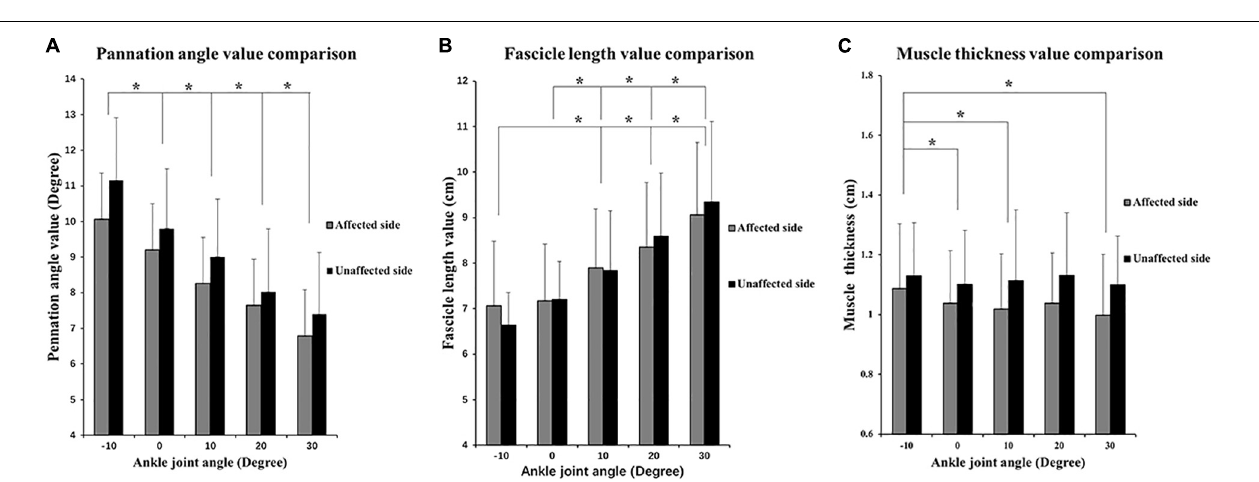
FIGURE 4 | Two-way repeated ANOVA with post hoc analysis results of ultrasonography parameters. (A) PA values comparisons among five ankle joint angles. (B) Fascicle length (FL) values comparison among five ankle joint angles, and significant difference was revealed between random two groups of ankle joint angles. (C) MT value comparison among five ankle joint angles. Y axis of A , B , and C did not start from 0 to demonstrate the variation trend of parameters versus joint angle as well as comparison between three parameters. ∗ P ≤ 0.05.